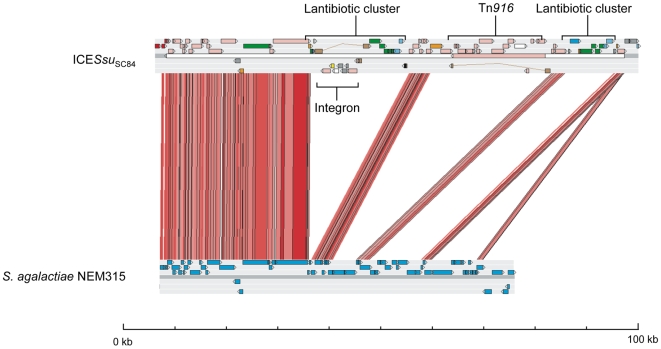
Comparisons of the ICE regions from S. suis strains SC84 and S. agalactiae NEM315.The results of a TBLASTX comparison of the ICESsu
SC84 from strain SC84 and S. agalactiae NEM315 Tn2424 is displayed using the Artemis Comparison Tool (ACT) [26].